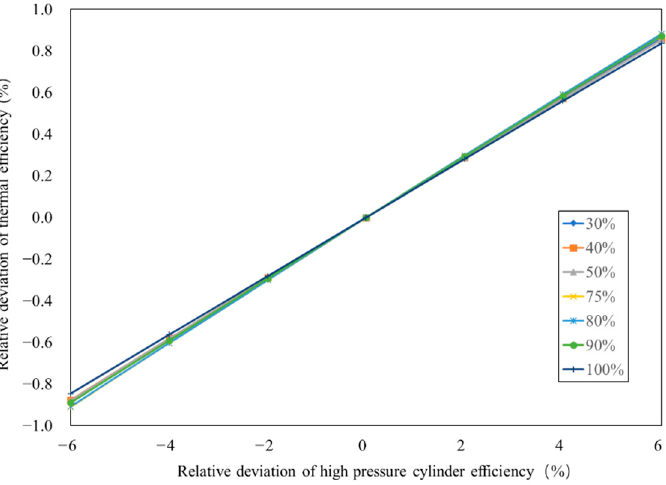
Figure 8. Variation in the relative deviation of thermal efficiency with high-pressure cylinder efficiency disturbance under different output power loads.